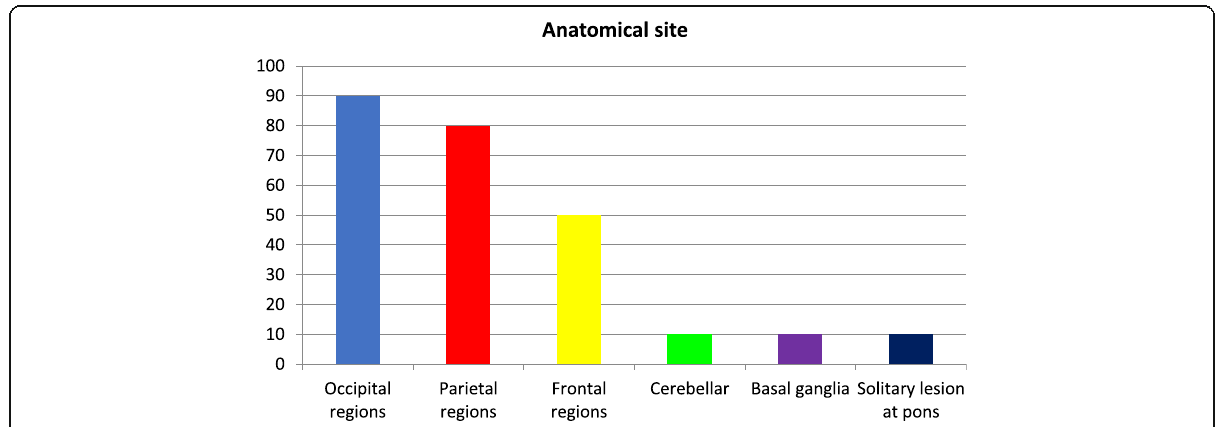
Fig. 4 Confirmed cases of PRES with involvement of the typical and atypical regions of the